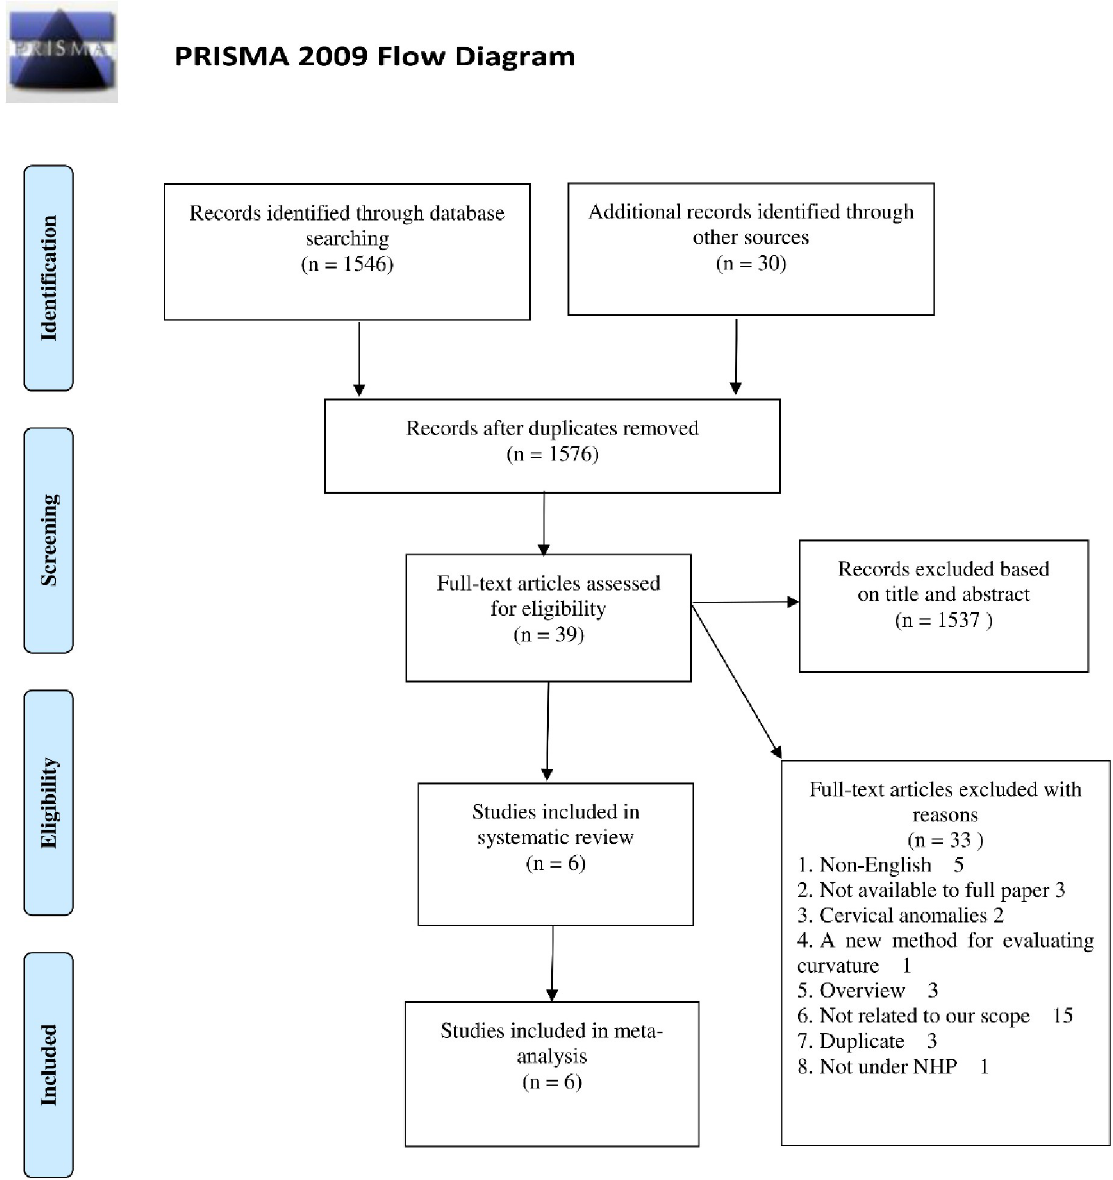
Fig 1. PRISMA flow chart for study